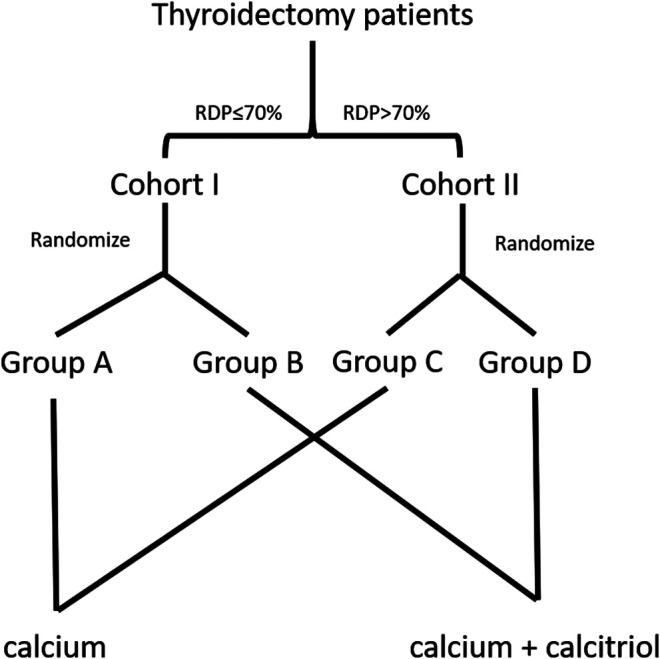
The flow diagram of enrollment and randomization in the randomized clinical trial. Patients were divided in two cohorts based on relative decline of parathyroid hormone (RDP)—Cohort I ≤70% and Cohort II >70%. Subsequently, patients in either cohort were allocated randomly into two groups, respectively. The standard procedure is done in Group A and Group D.